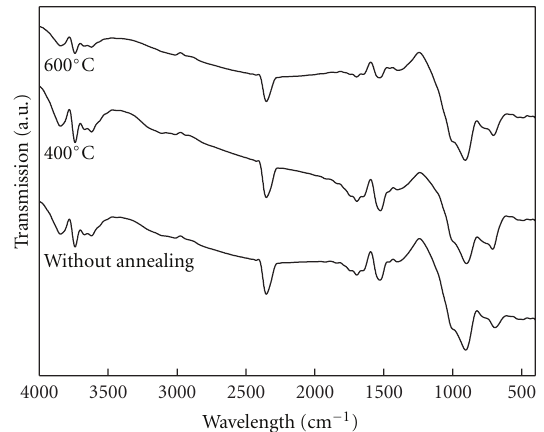
Figure 2: TG-DTA curves of the ITO gel.